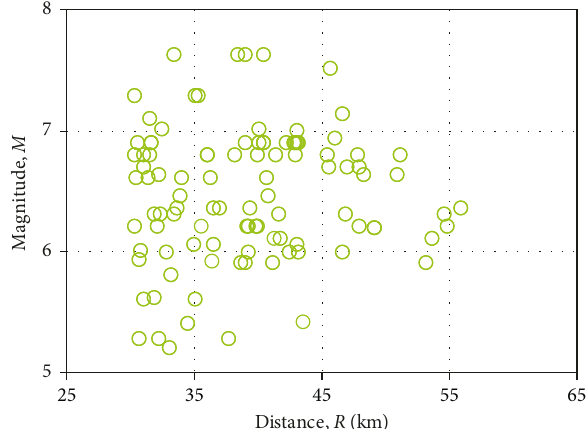
Figure 3: Distribution of the 200 earthquake ground motions in the M - R plane.